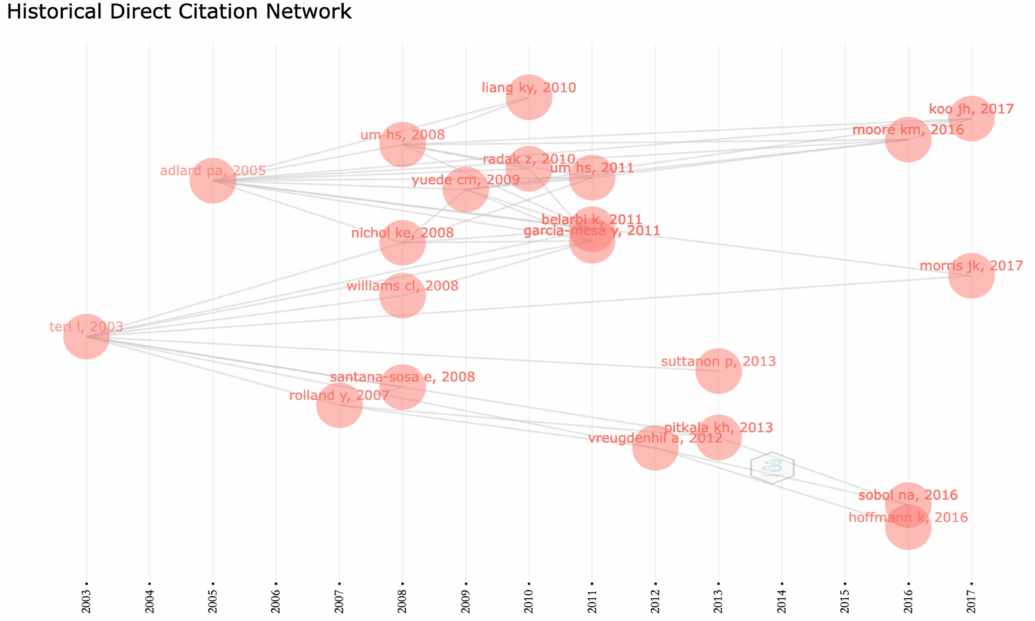
Figure 5. The historical direct citation network of studies on AD exercise